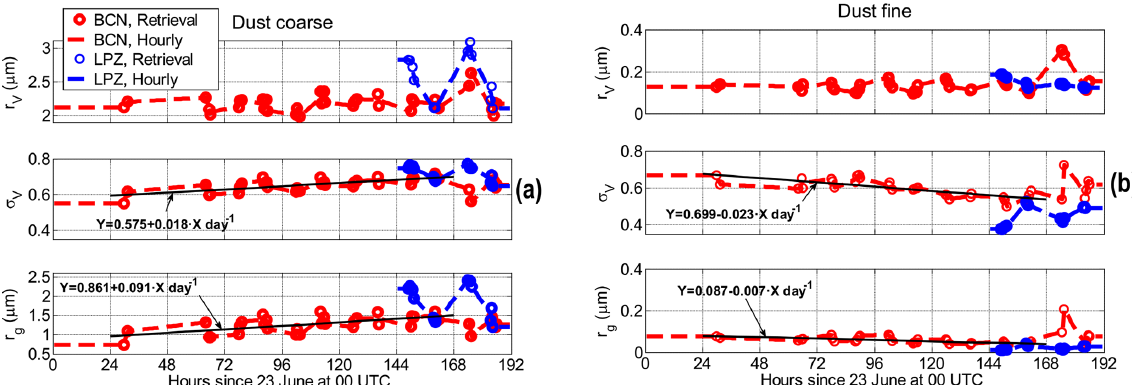
Figure 1. AERONET volume median radius and standard deviation and corresponding geometric median radius in BCN (red) and LPZ (blue) for (a) the coarse mode and (b) the fine mode. Circles indicate retrievals, and the dashed lines represent the hourly interpolated data. The legend in the first plot applies to all plots. The black lines are a linear fit of the retrievals in BCN over the period 24–29 June.